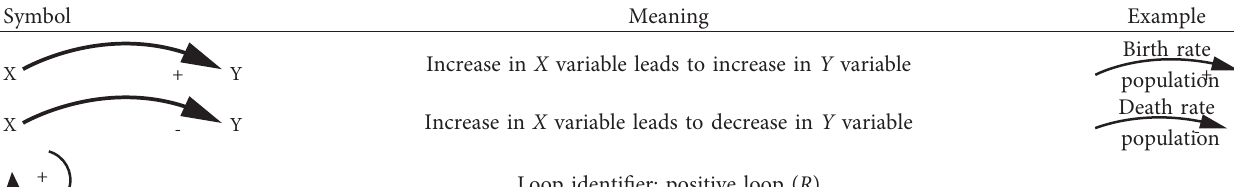
Table 1: Symbols, meanings, examples, and charts in causal loop diagrams [27].